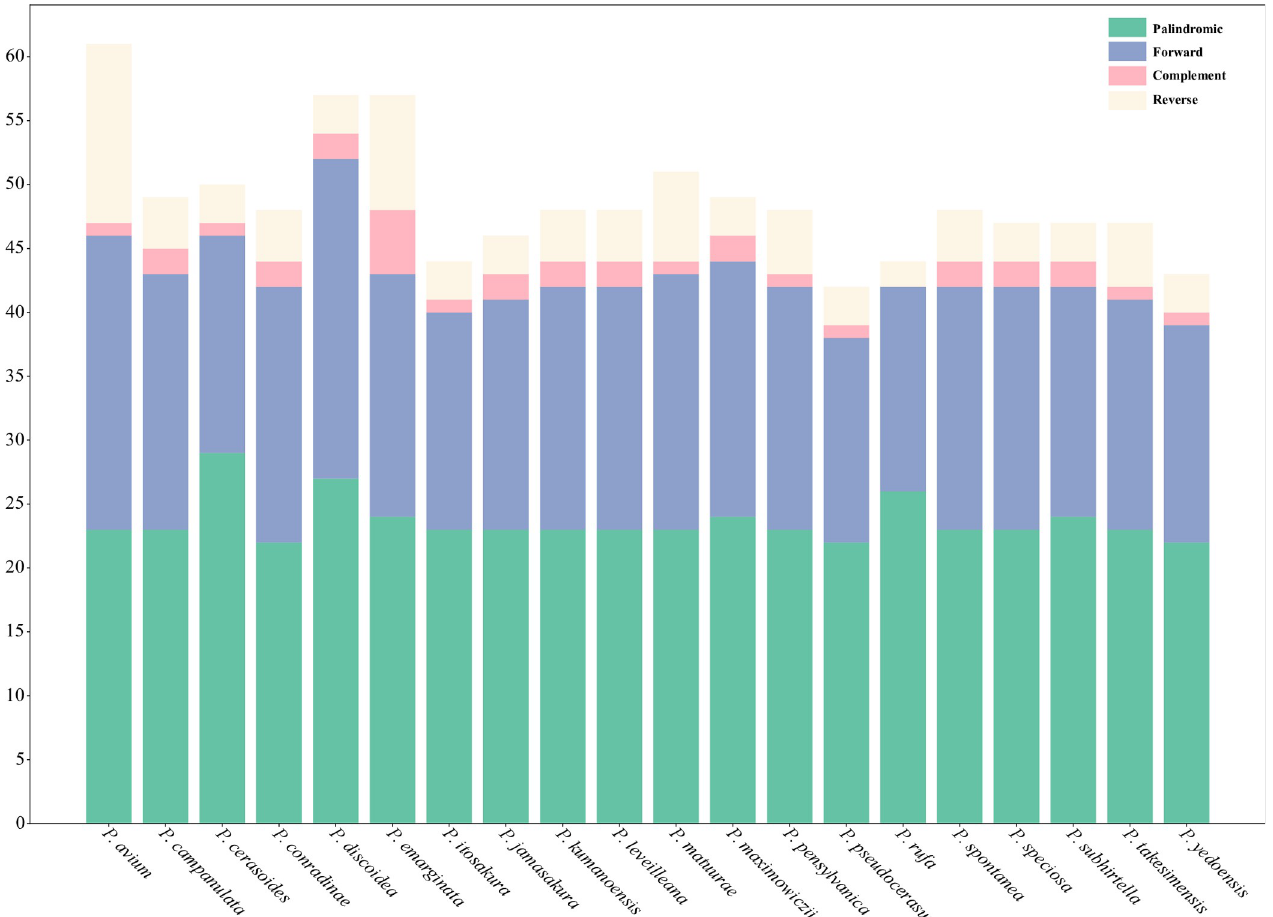
Fig 4. Investigation of repeated sequences in subg. Cerasus plastomes. The 20 subg. Cerasus plastomes studied have four repeat types, which are forward (F), reverse (R), palindrome (P) and complement (C).